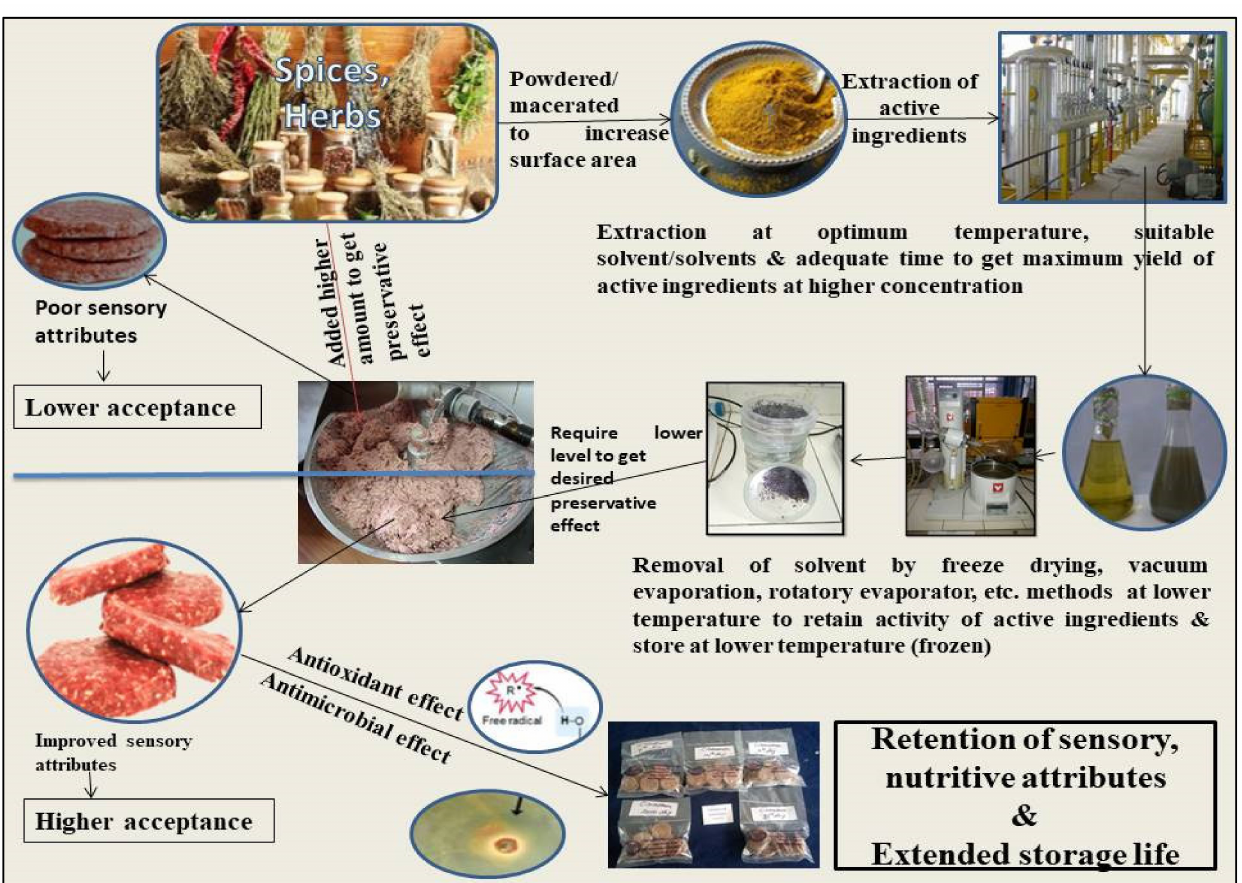
Figure 2. Plant extract as natural preservatives in